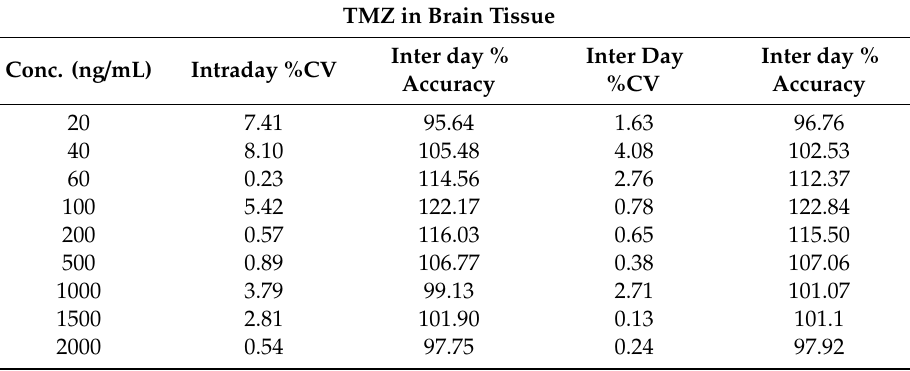
Table 2. Percentage of CV and percentage of accuracy of the quantitation of TMZ for intraday and inter-day runs in brain